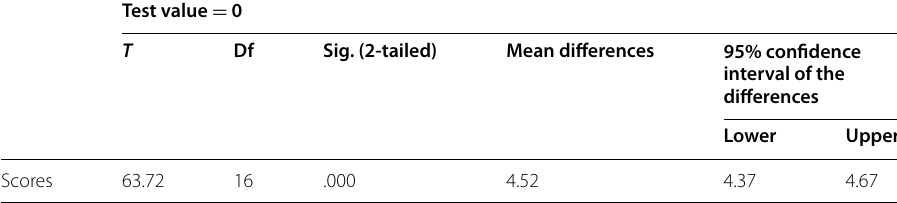
Table 16 One-sample test of the attitude